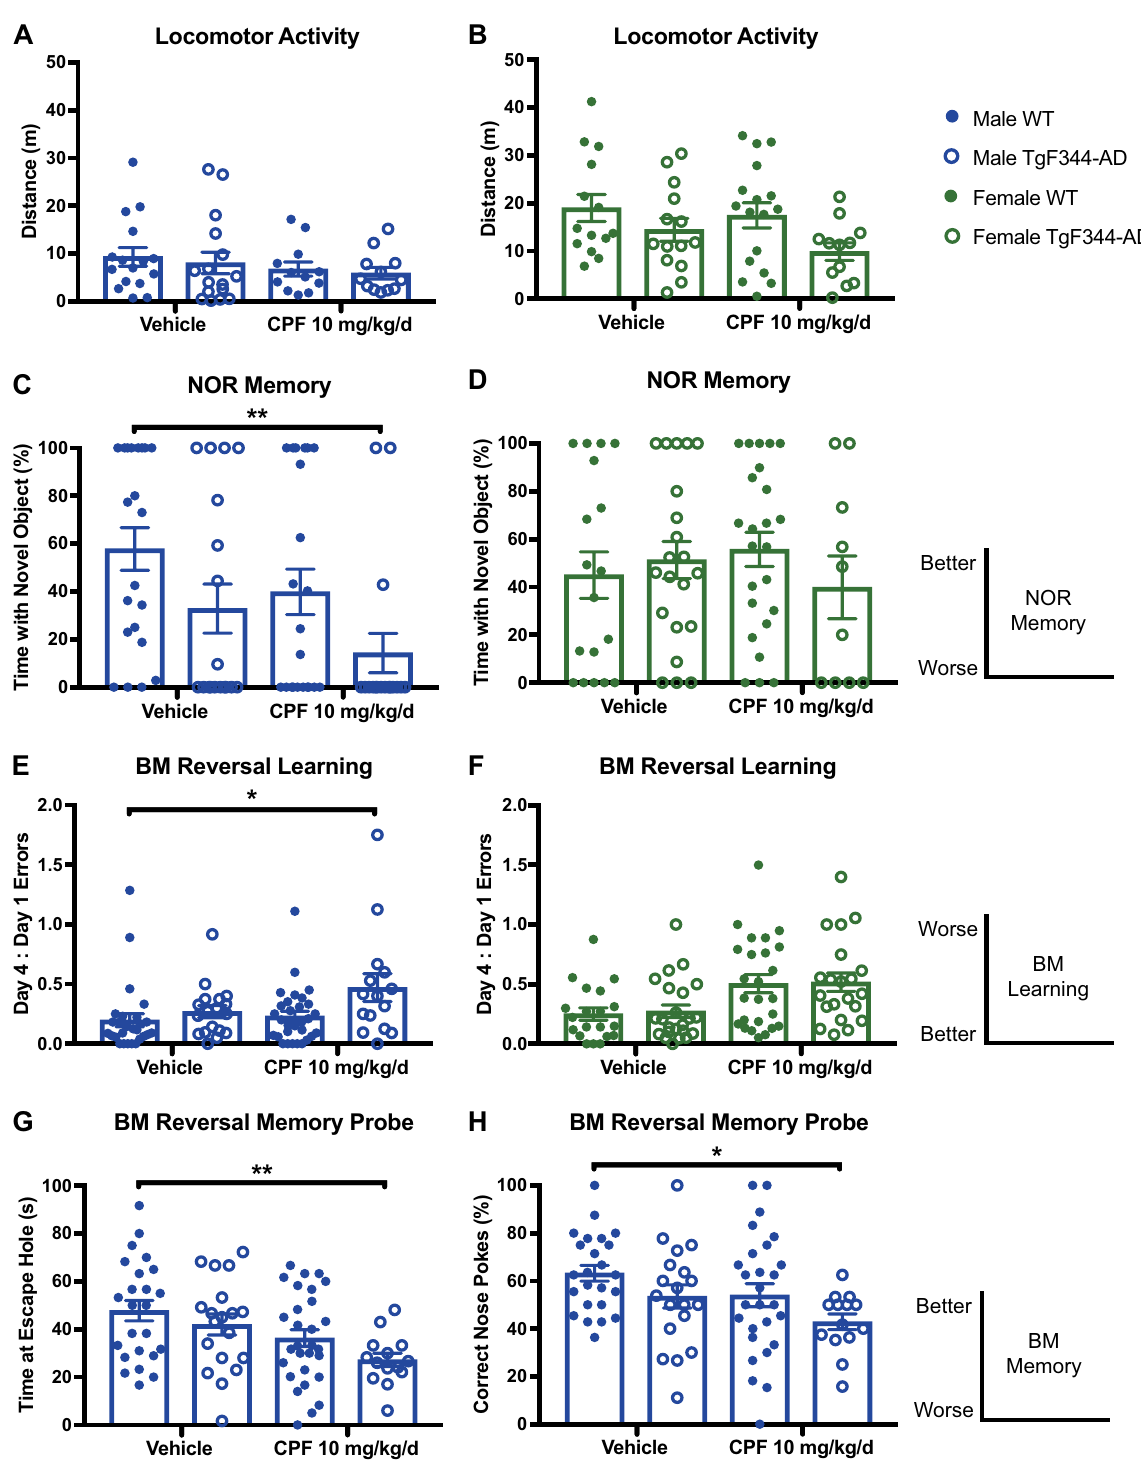
peptides) or 5 M guanidine-HCl (i.e., insoluble A β peptides) was further analyzed by A β 1 – 40 and A β 1 – 42 peptide ELISAs. Soluble and insoluble A β 1 – 40 and A β 1 – 42 were increased in TgF344-AD male and female rats relative to sex-matched controls (Fig. 5d, e), consistent with previous reports. 11 However, no signi fi cant differences were observed as a function of CPF exposure in any